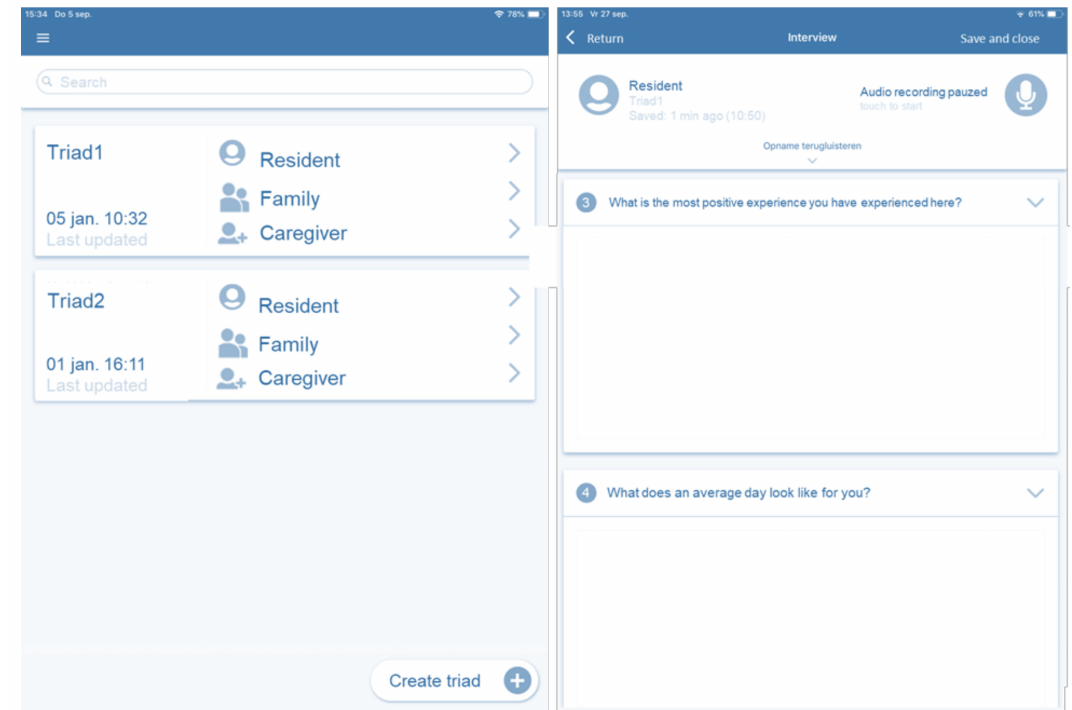
Figure A2. Screen shots from the Connecting Conversations app: triad list (left) and conversation with resident